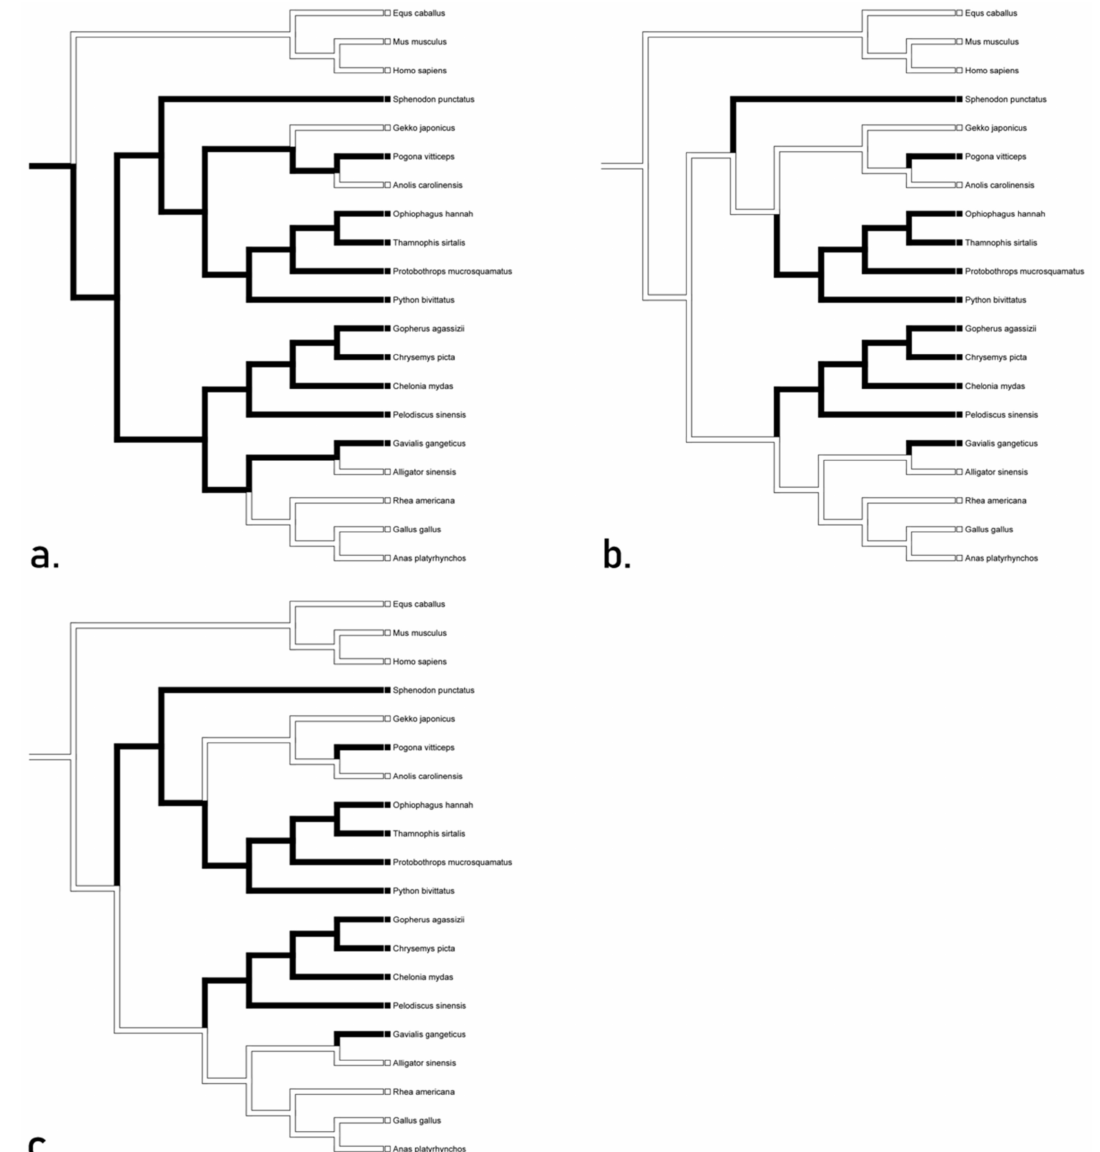
Figure 7. Character optimization of TLR 22 using accelerated ( a ) delayed ( b ), and mixed ( c ) transfor- mations. The accelerated transformation proposed conservation throughout Reptilia with a loss in Gekko , Anolis , and Alligator while delayed transformation also suggests convergence between Sphen- odon , Pogona , Serpentes , Testudines , and Gavialis . Mixed transformation suggests conservation in all Lep- idosauria except for losses in Gekko and Pogona , as well as convergence with and within